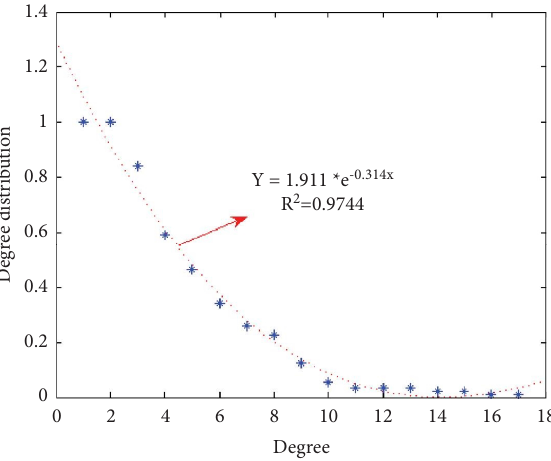
Figure 11: Te degree distribution of ACMN.